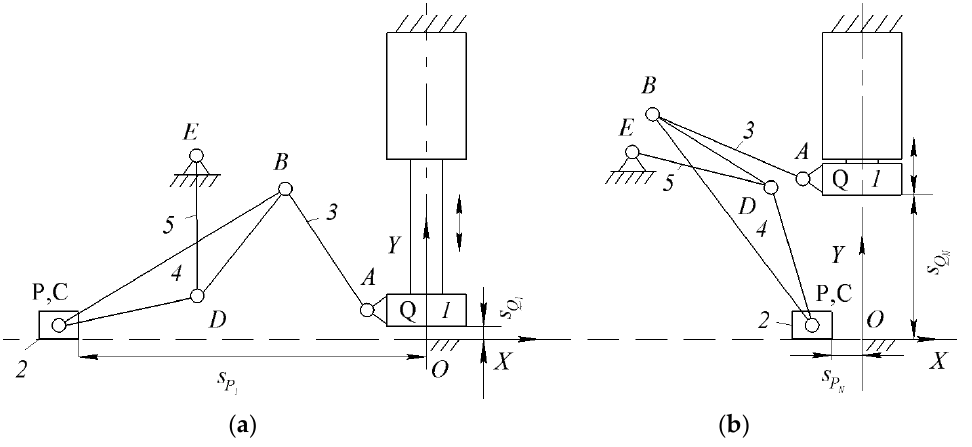
Figure 4. ( a ) lower extreme and ( b ) upper extreme positions of the slider Q .